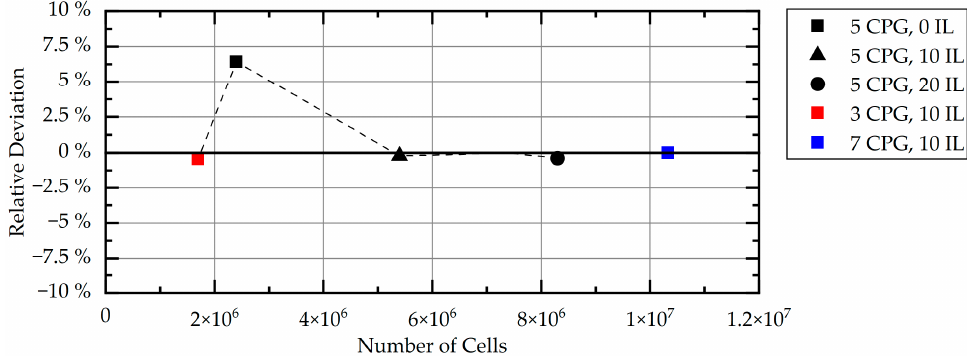
Figure 6. Relative deviation of the heat transfer through the recuperator for different mesh variations.